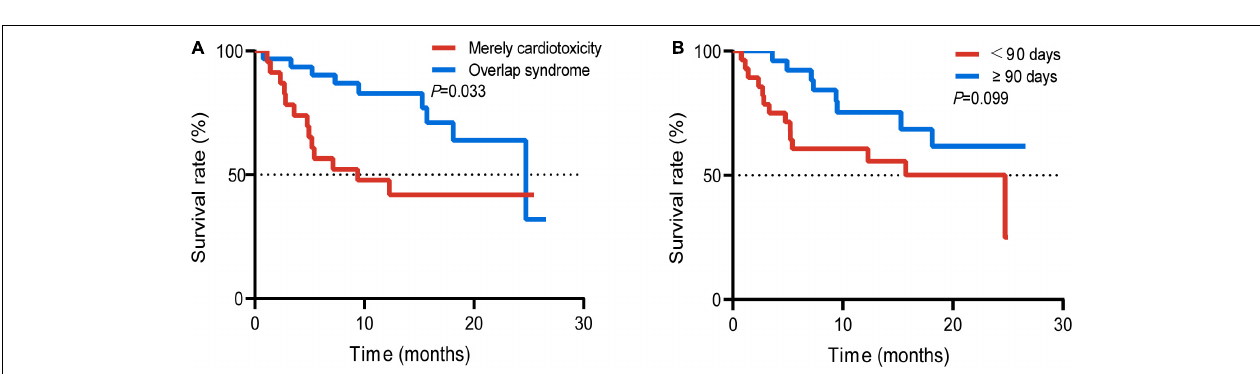
FIGURE 4 | Survival curve of the patients suffered respiratory tumor with or without cardiotoxicity (A) ; patients suffered digestive tumor with or without cardiotoxicity (B) .